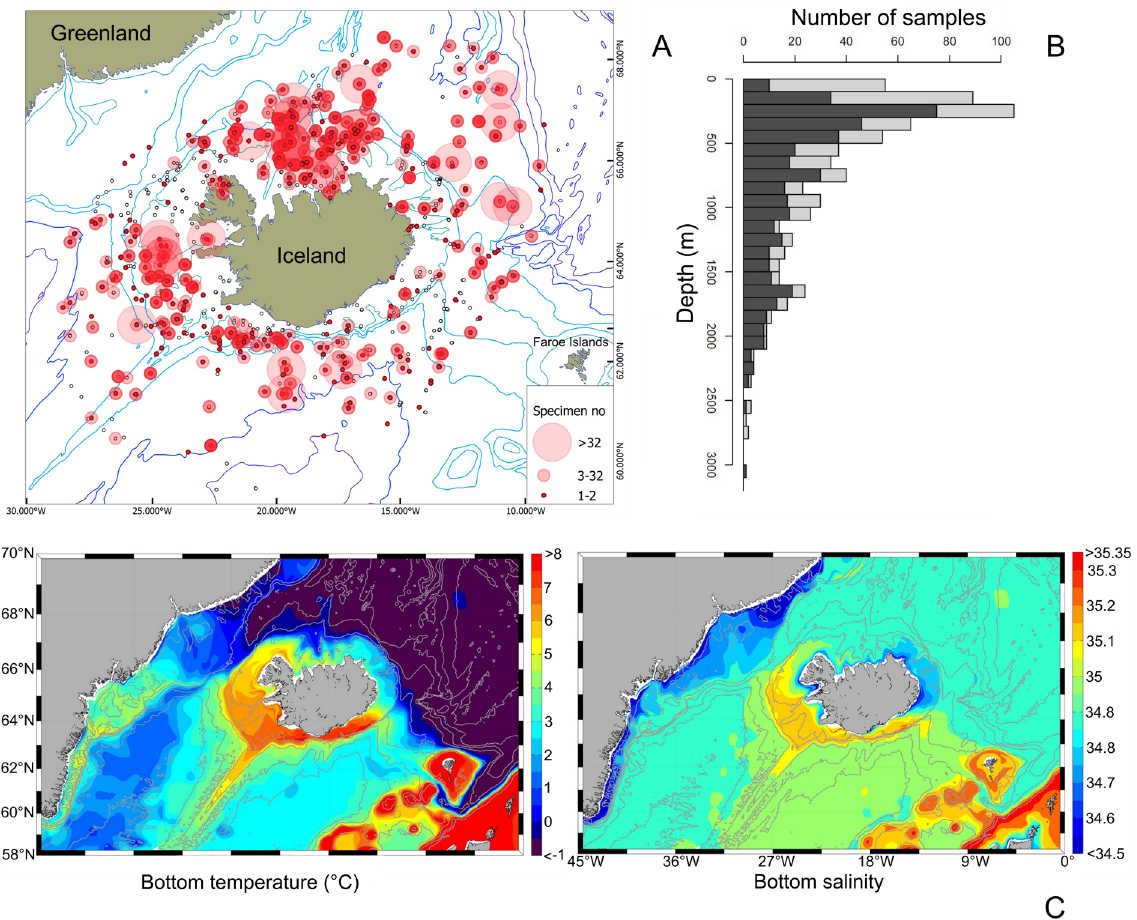
Fig. 16. A . Combined distribution of the 14 species of Nodosariinae Ehrenberg, 1838. Open black circles are locations of BIOICE samples examined for Foraminifera. Red filled circles show occurrence of Nodosariinae as rare (1–2 specimens), frequent (3–32 specimens), and common (> 32 specimens); circle area increases proportional to average size of the first two bins i.e., rare (1.5), frequent (15), and common (150). B . Depth distribution of BIOICE samples per 100 m depth intervals overlaid with samples containing Nodosariinae in darker grey. C . Interpolated gridded mean bottom water properties for the period 1900–2008: temperature (left) and salinity (right). Depth contours are isobaths at 250 m, 500 m, 1000 m, 1500 m, 2000 m, and 3000 m (Jochumsen et al . 2016: 81, fig. 2; reproduced with permission from ©